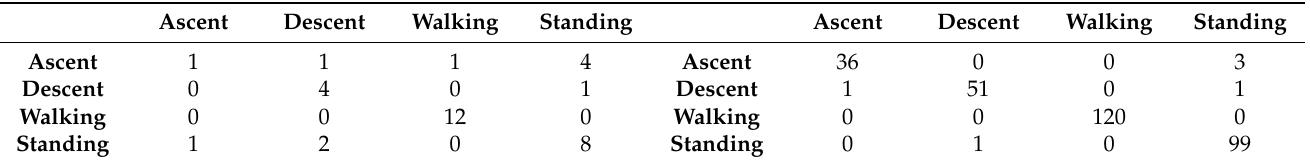
Table 14. Confusion matrix of SS local dataset– ResNet50 (initial results—left, final